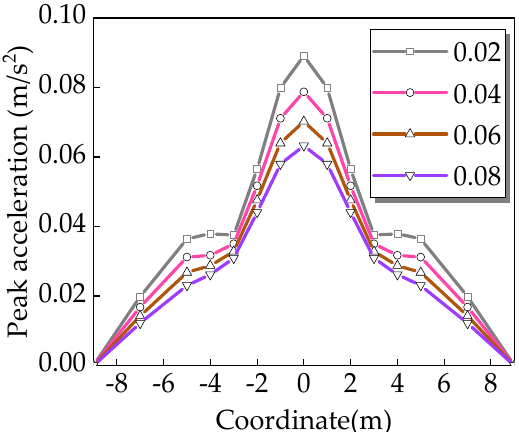
Figure 9. Effect of damping on peak acceleration response.